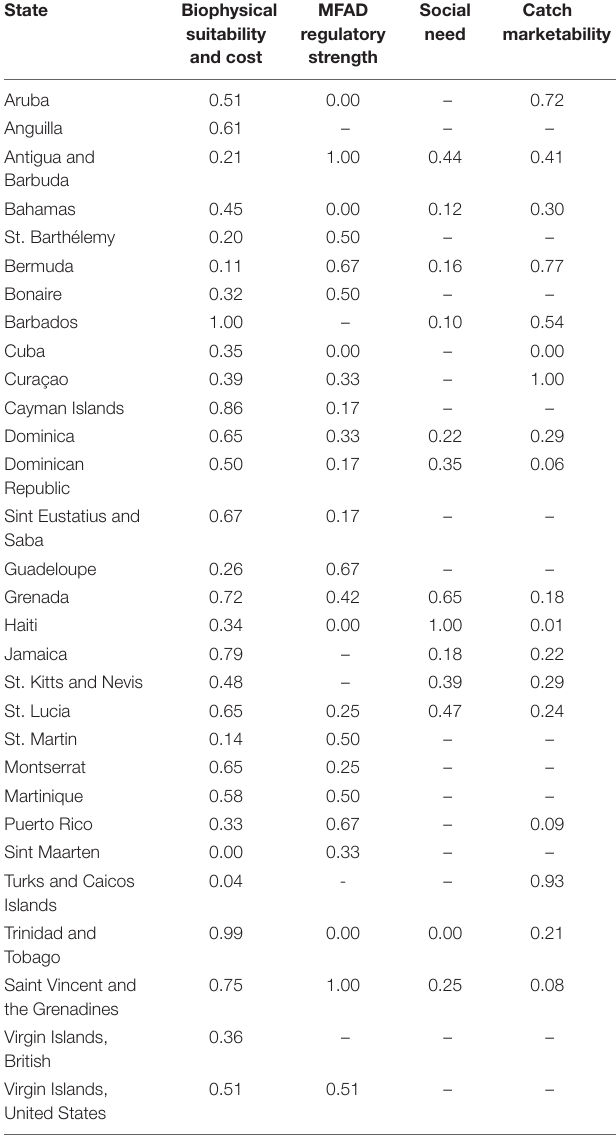
TABLE 1 | Framework component values by